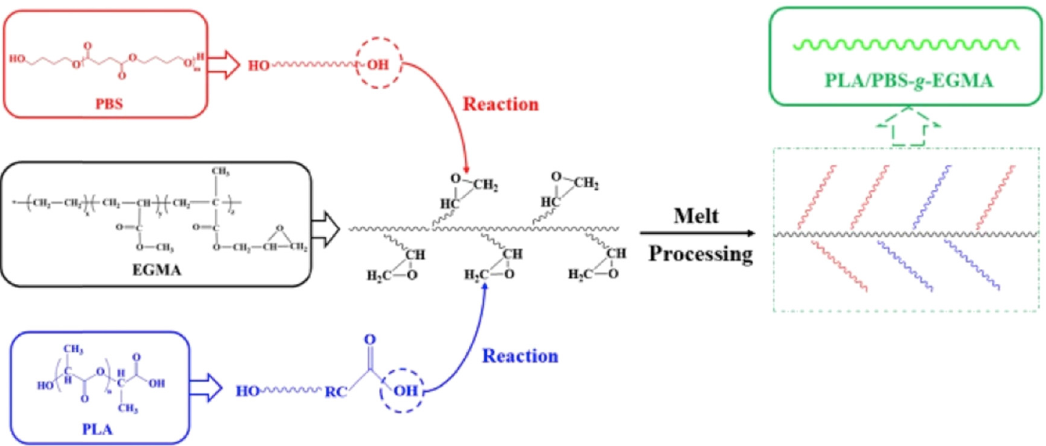
Figure 9: Possible in situ reactions among PLA, PBS, and EGMA during melt compounding ( 77 ) . Copyright 2019. Reproduced with permission from Elsevier.